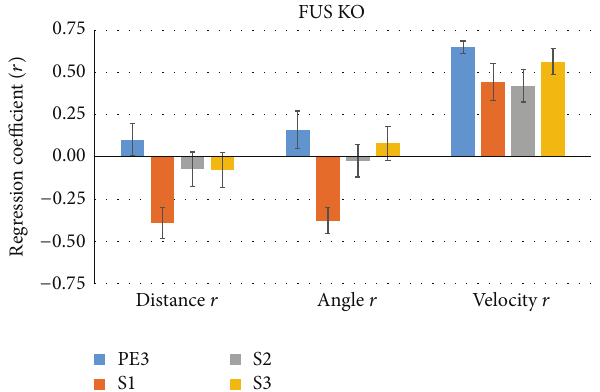
Figure 5: Proximity, orientation, and velocity are correlated with S1 trial sniff rate in FUS KO mice. The same as Figure 4, but for FUS KOmice( 𝑛 = 13 ),showingsimilarresultsbutwithstrongernegative correlation between head angle and sniff rate during S1 trials. Again, velocity consistently positively correlated with sniff